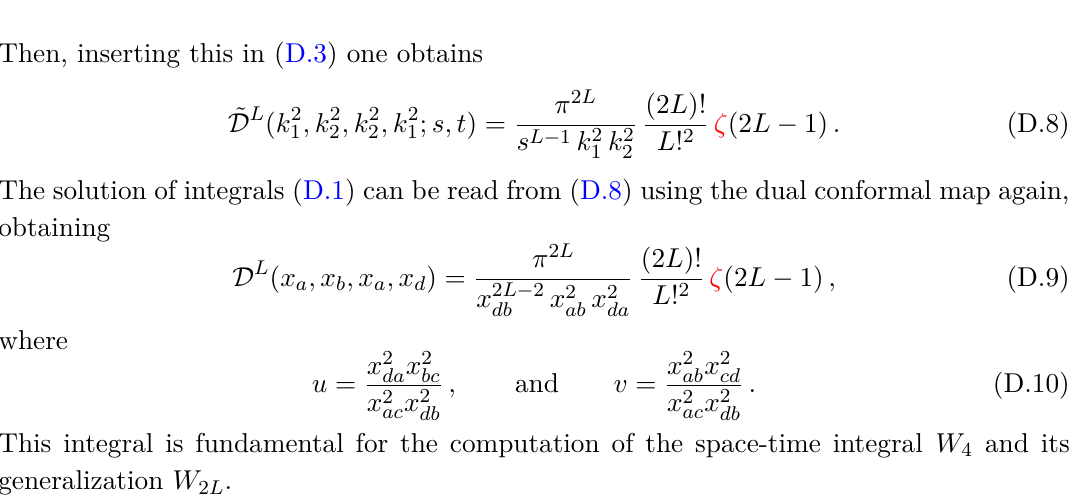
Figure 12. W 4 with its point-splitting representation. All the propagators come from chiral fields, so they can be simply represented by plain